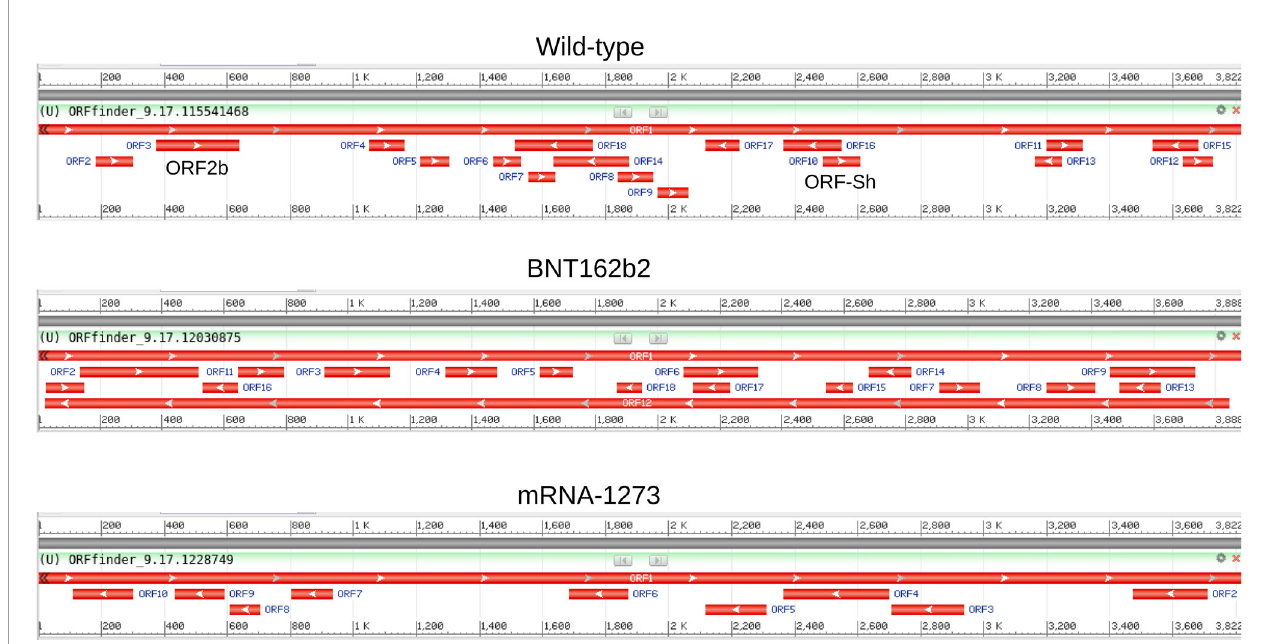
FIGURE 2 | ORFs detected on the wild-type, BNT162b2, and mRNA-1273 spike sequences. The ORFs identi fi ed using NCBI ORF fi nder for the ORFs detected on the wild-type (top), BNT162b2 (middle), and mRNA-1273 (top) spike sequences are depicted. The presence of ORF2b and ORF-Sh (ORF3 and ORF10, respectively, in the NCBI ORF fi nder output) are noted on the wild-type sequence